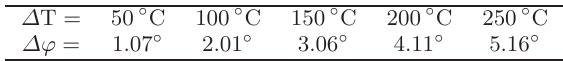
Fig. 7. Initial deflexion of raster scanning actuator. Table 2. Changes of the deflexion angle for the raster scanning actuators due to changes of